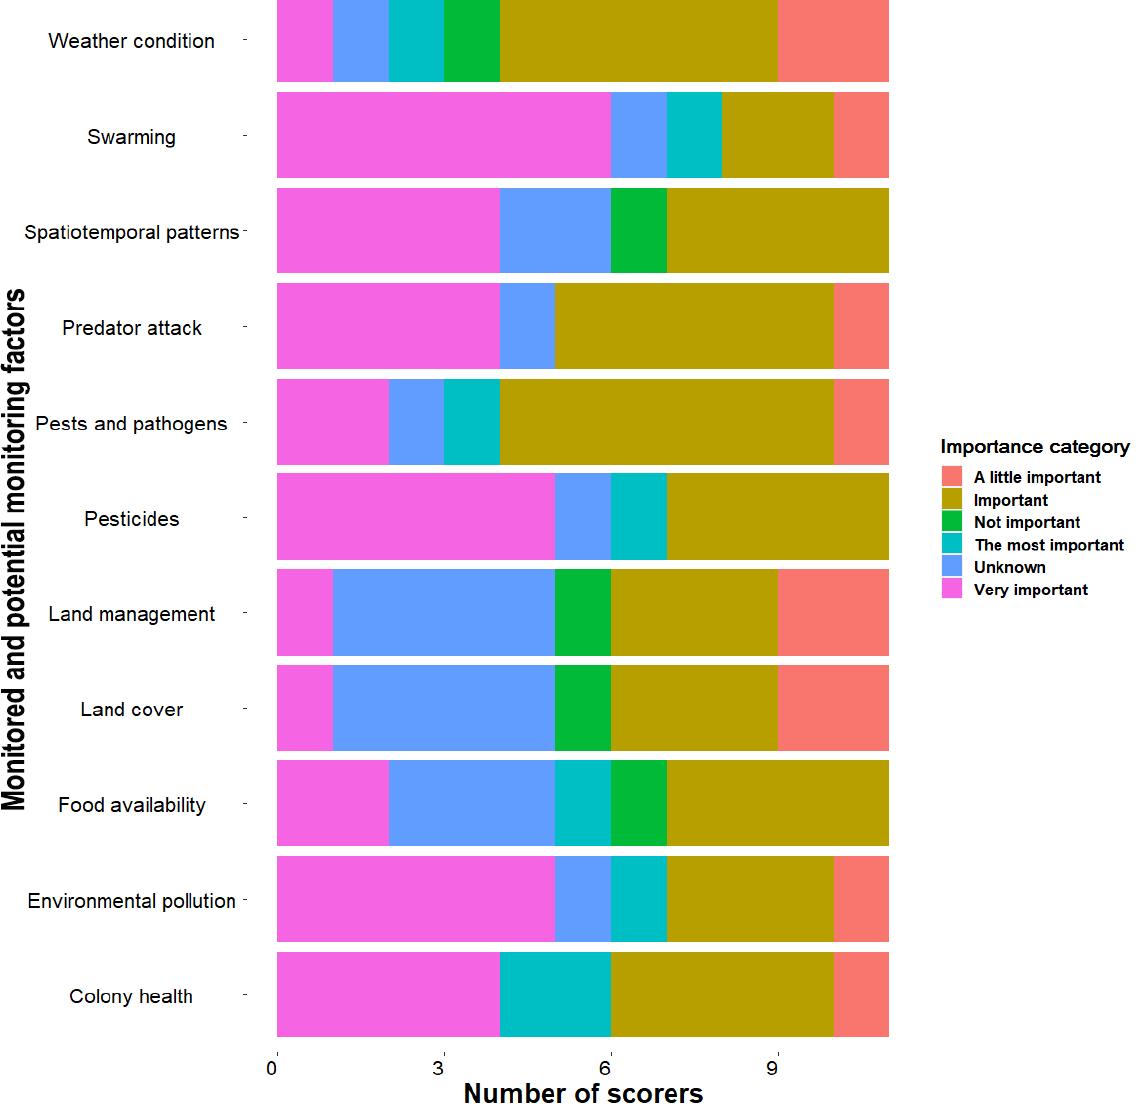
Figure 4. Final breakdown of importance level scoring for each factor for their potential monitoring via honeybee colony acoustics.